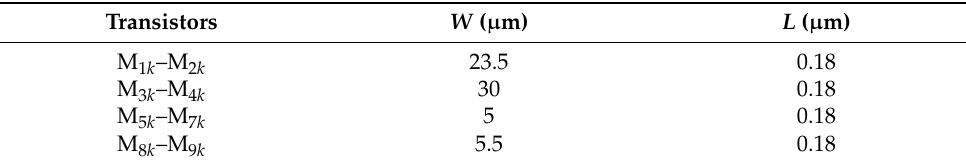
Table 2. Aspect ratios of the CMOS transistors of the VDGA in Figure 2.